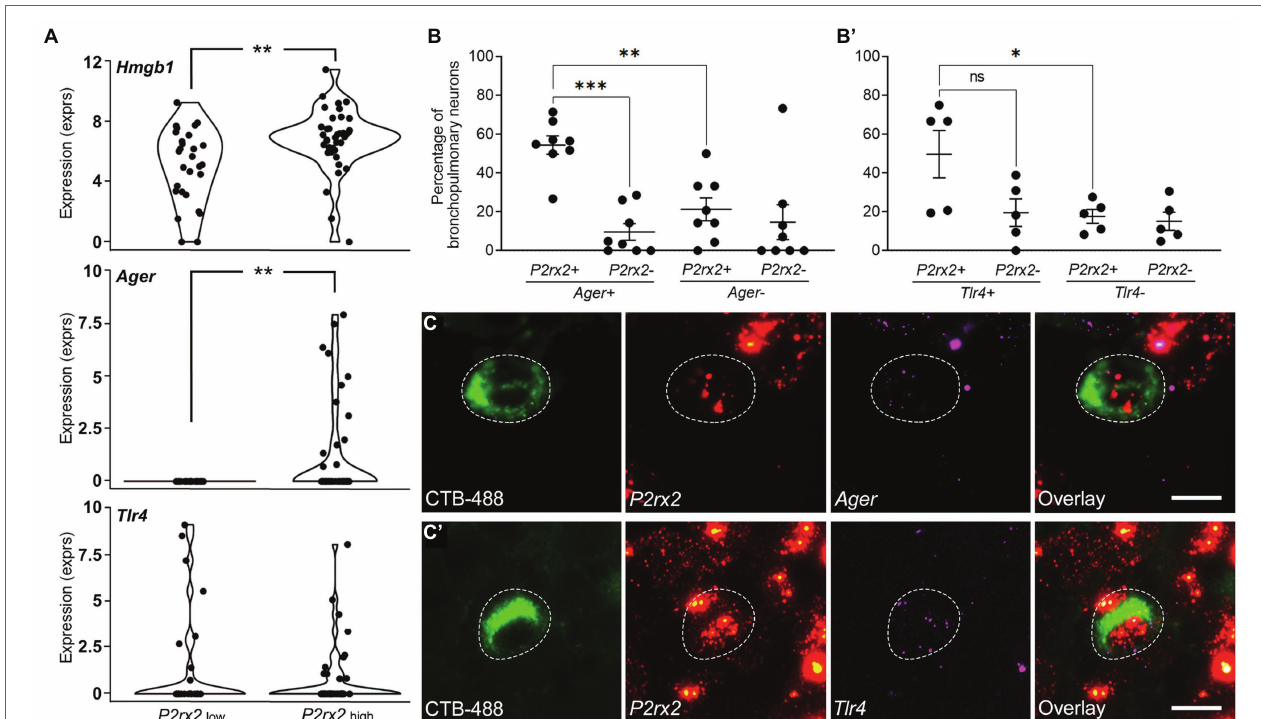
FIGURE 1 | Gene expression of Hmgb1 , Ager (RAGE), and Tlr4 in bronchopulmonary vagal sensory neurons clustered by P2rx2 expression levels. (A) Violin plots of single cell RNAseq data showing the mean log 2 CPM values for P2rx2 and Hmgb1 , Ager , or Tlr4 genes correlated to P2rx2 expression. P2rx2 LOW and P2rx2 HIGH are presumed jugular-like and nodose-like bronchopulmonary vagal sensory neurons, respectively (Mazzone et al., 2020). ** p < 0.01 significantly different mean expression levels. RNAscope was performed on bronchopulmonary vagal sensory neurons for Ager (B) or Tlr4 (B’) and quantified relative to percentage of neurons showing a presence or absence of P2rx2 expression. Representative photomicrographs demonstrate bronchopulmonary neurons (retrogradely traced with CTB- 488, green) and the expression of P2rx2 (red) and either (C) Ager or (C’) Tlr4 (magenta). Neuronal soma outlined with dashed lines. Scale bar equals 20 μm. * p < 0.05; ** p < 0.01; and *** p < 0.001 significantly different expression levels as determined by multiple comparisons, two-way ANOVA. ns, not